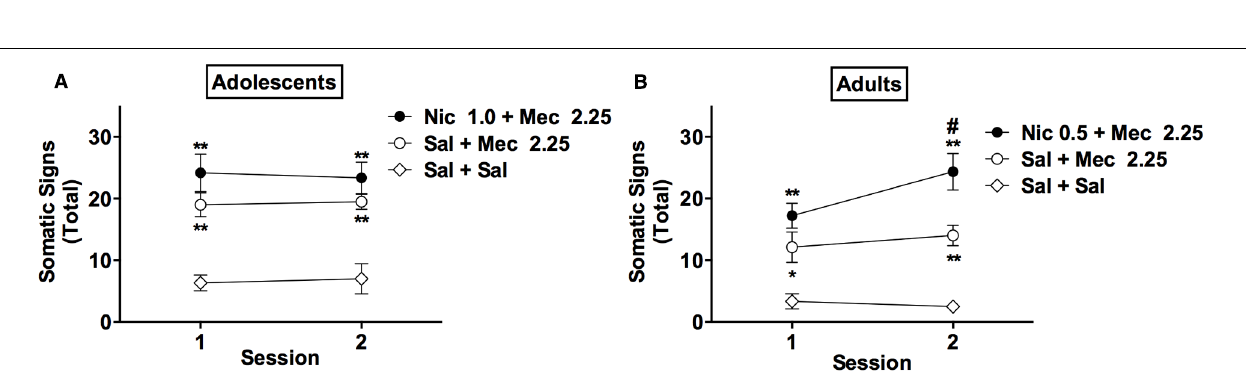
FIGURE 3 | Effects of mecamylamine alone and mecamylamine combined with nicotine on somatic signs in adolescents and adults. Mean ( (cid:6) SEM) total number of somatic signs during each test session in adolescents (A) and adults (B) in Experiment 3. * , **Significantly different from Sal + Sal group for that age, p < 0.05, 0.01. # Adult Nic 0.5 + Mec 2.25 group significantly different from adult Sal + Mec 2.25 group at that session, p <